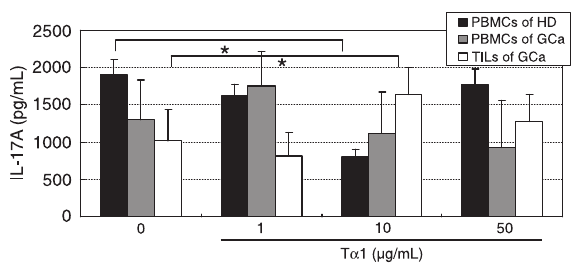
Figure 4. Effect of Tα1 on IL-17A secretion in PBMCs from healthy donors (HD) and gastric cancer patients (GCa) and in TILs from gastric cancer patients. PBMCs and TILs were cultured with PBS or 1, 10, or 50 µg/mL Tα1 for 72 h. Th17A levels were determined by a Bio-Plex cytokine assay. PBMCs = peripheral blood mononuclear cells; TILs = tumor-infiltrating lymphocytes. Data are reported as means ± SD for 3 separate experiments (*P < 0.05, t